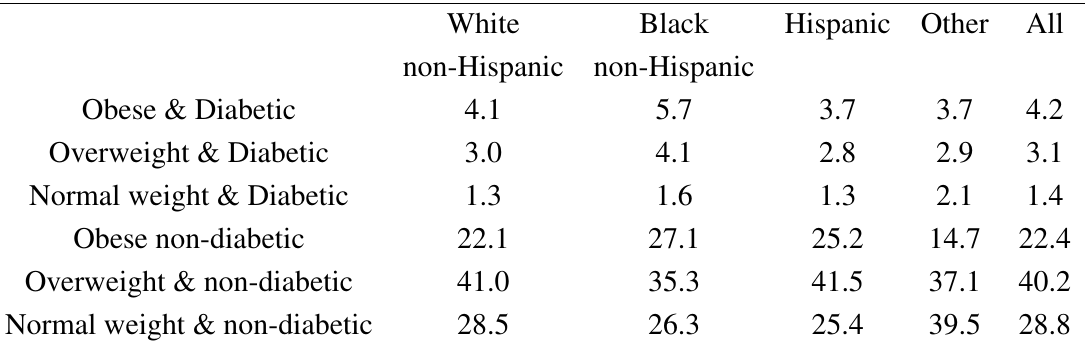
Table 2 does not control for interrelations between risk factors (e.g., between race and education), and a regression is required. Table 2 . Percentage prevalence of obesity-diabetes status, by